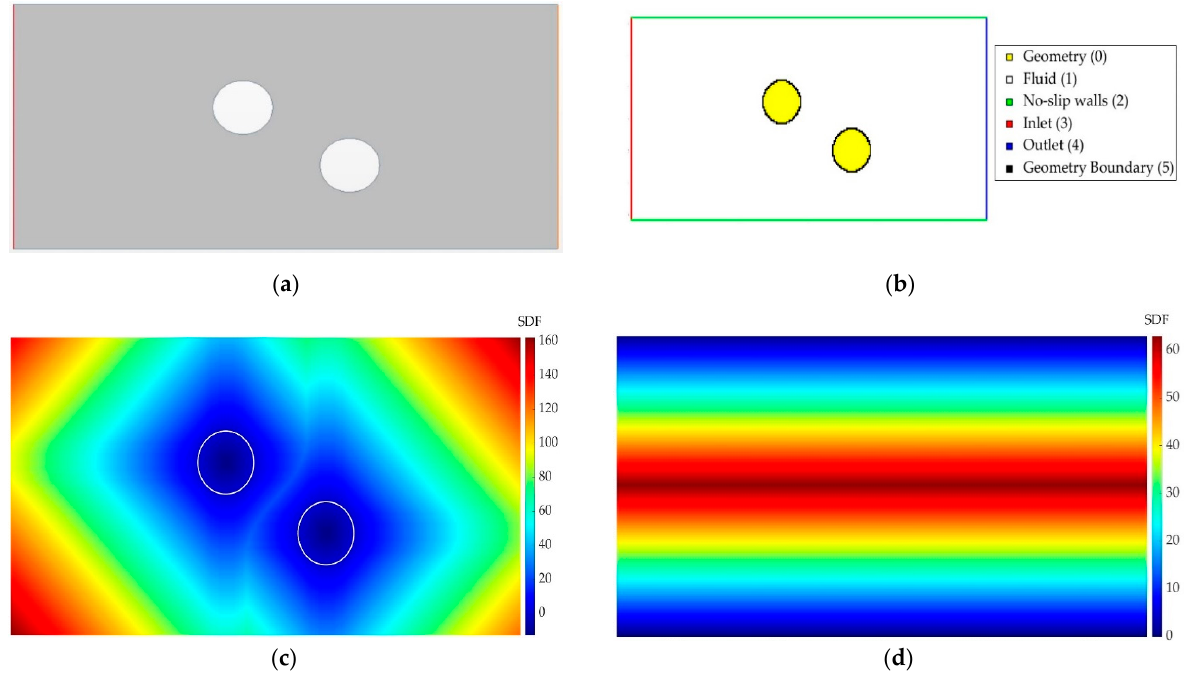
Figure 11. Information about the used domain with multiple geometry. ( a ) Numerical domain; ( b ) FRC layer; ( c ) SDF layer of the geometries (the contour of the geometries is drawn in white); ( d ) SDF layer of the walls.